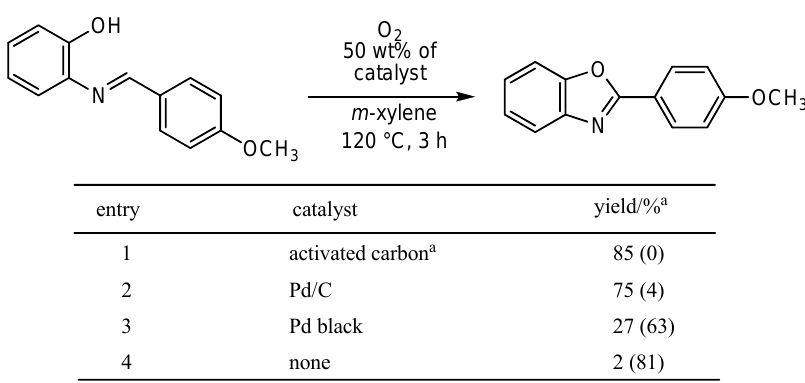
Table 7. Effect of activated